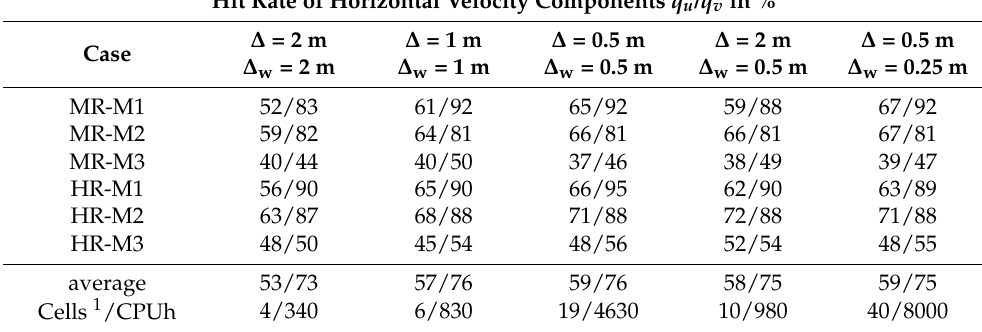
Table 4. Hit rate of the wind field simulations according to VDI 3783/9, Threshold W = 25%, D = 0.08, for all cases for five mesh types ( ∆ = mesh size, ∆ w = refined mesh size at walls). Hit Rate of Horizontal Velocity Components q u / q v in